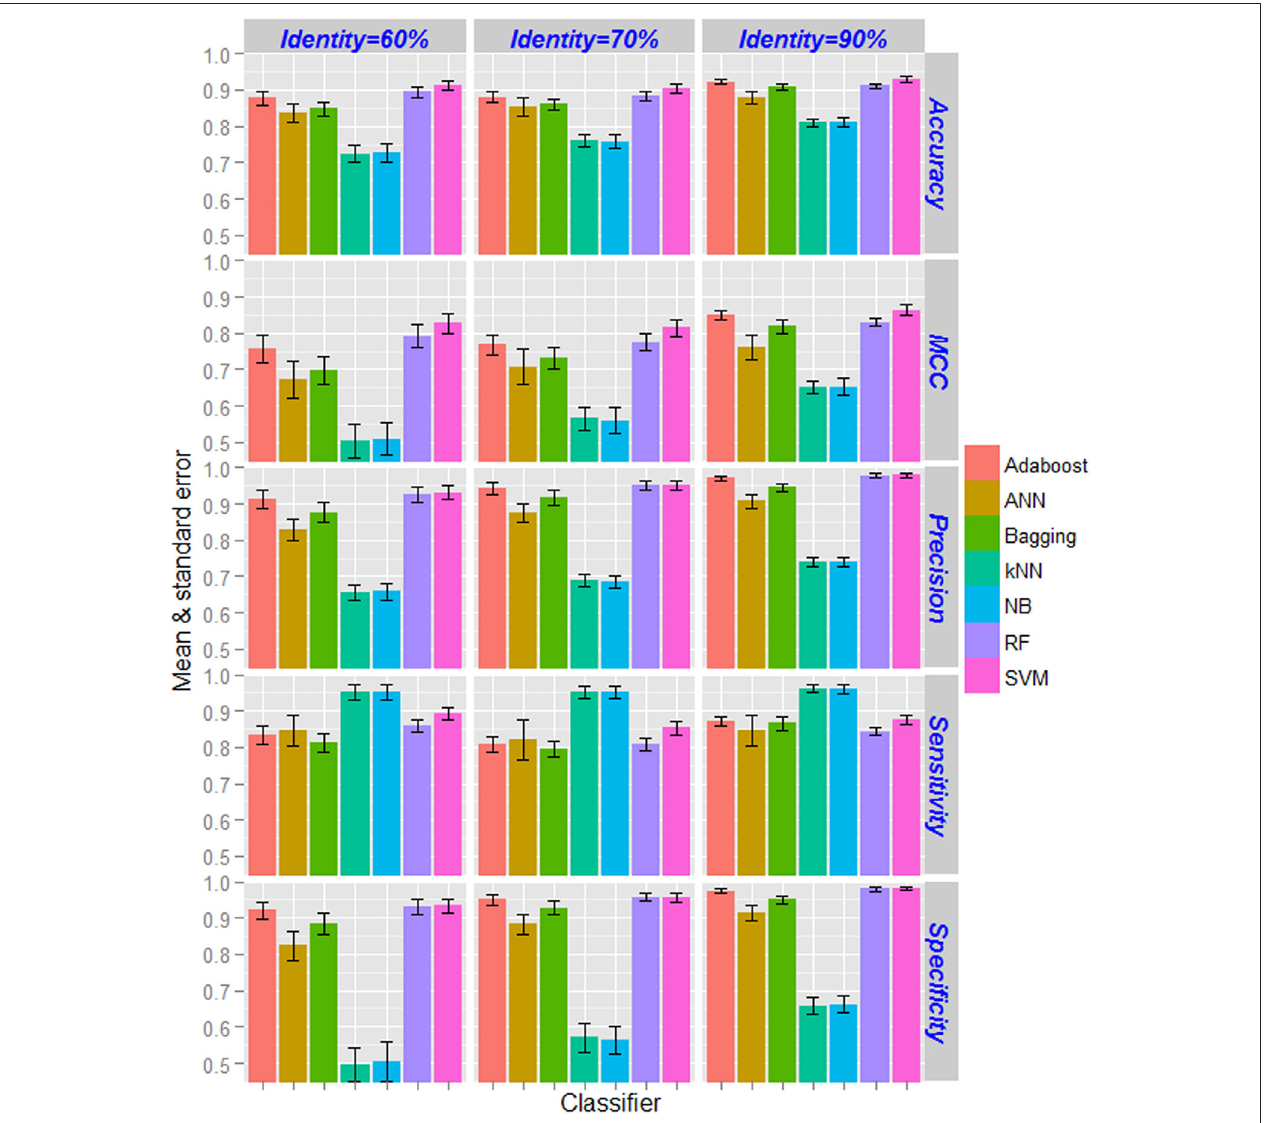
FIGURE 3 | Bar diagrams of the estimates of performance metrics for different supervised learning techniques. The performance of SVM was compared with other six machine learning approaches with respect to classification of nif and non-nif proteins with CTD feature sets. Classification accuracies increased with increase in pair-wise sequence identity level in the positive dataset. The accuracies of kNN and NB classifiers are observed to be lowest, whereas highest accuracies are observed for SVM followed by RF classifier. The performance metrics of SVM are also found to be more stable (less standard error) as compared to the other